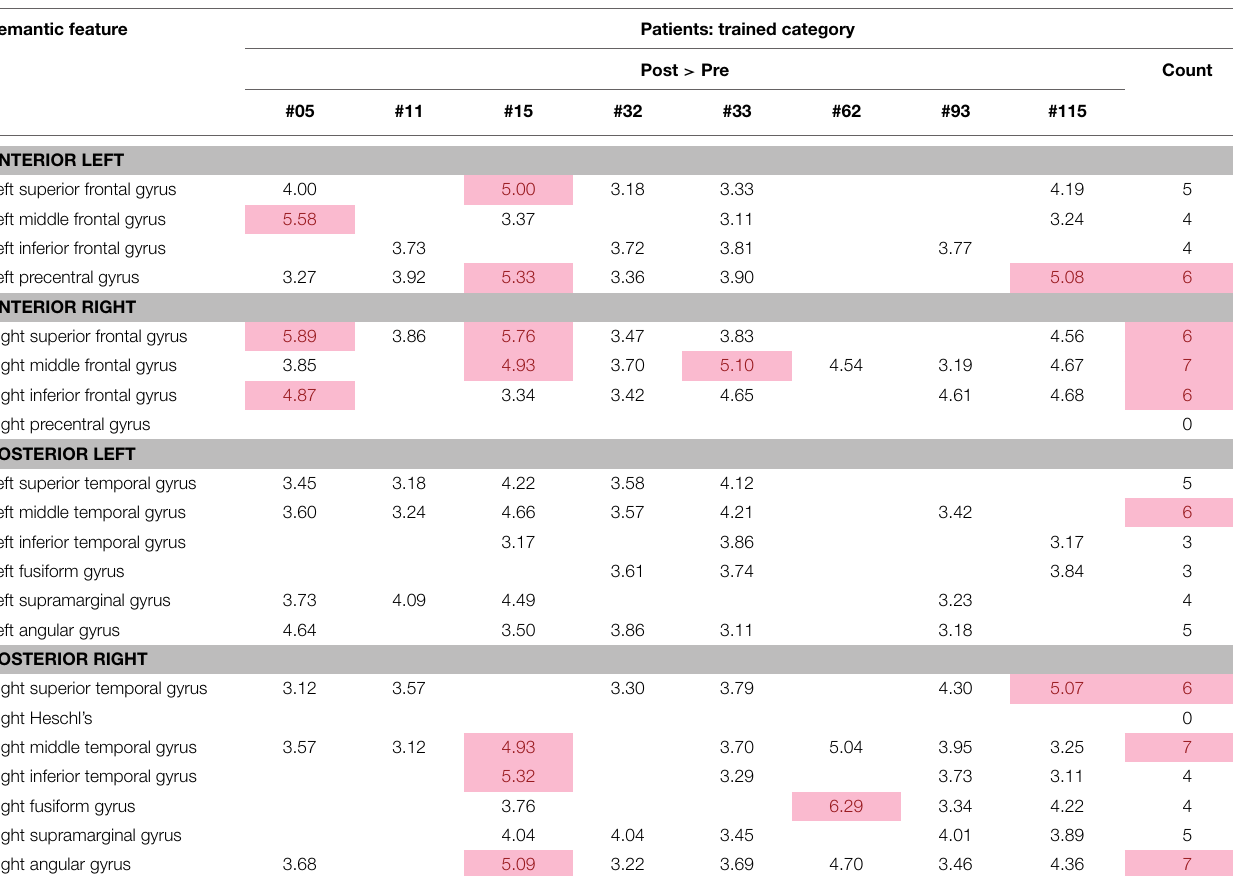
TABLE 7 | Regions of activation across patients in the post-rehabilitation > pre-rehabilitation contrast with T -values for the semantic feature verification task. Semantic feature Patients: trained category